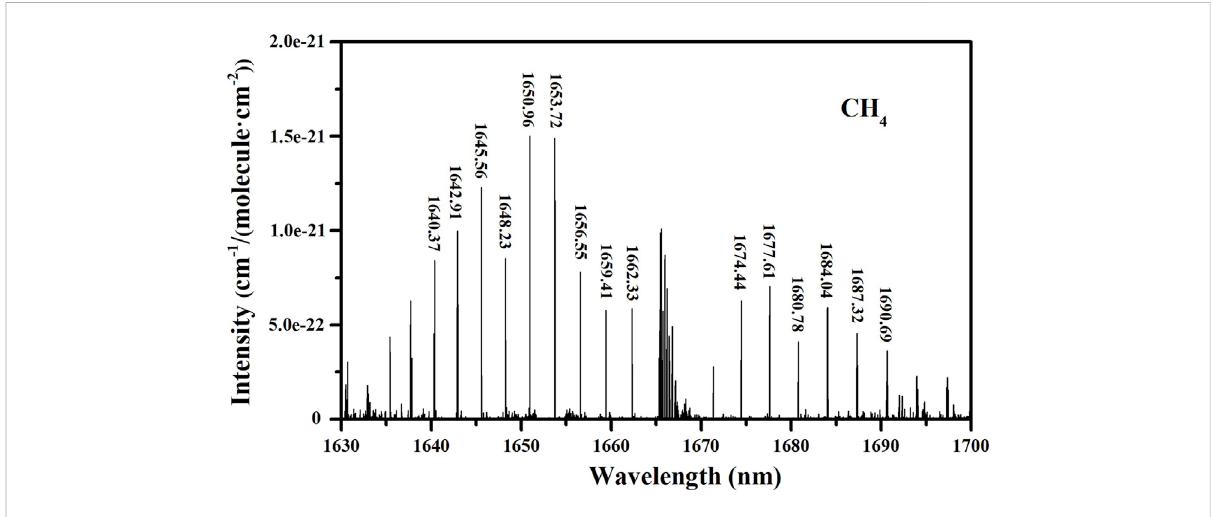
FIGURE 1 Absorption spectra of methane gas in the 1650 nm